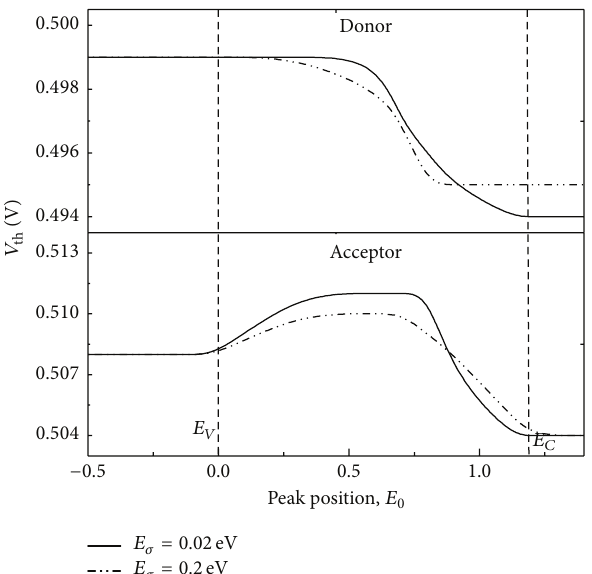
Figure 4: Threshold voltage 𝑉 versus the peak position 𝐸 0 of high distribution and low distribution with donor-type ITs and acceptor-type th = 𝑉 = 0.5 V. ITs; 𝑉 GS DS